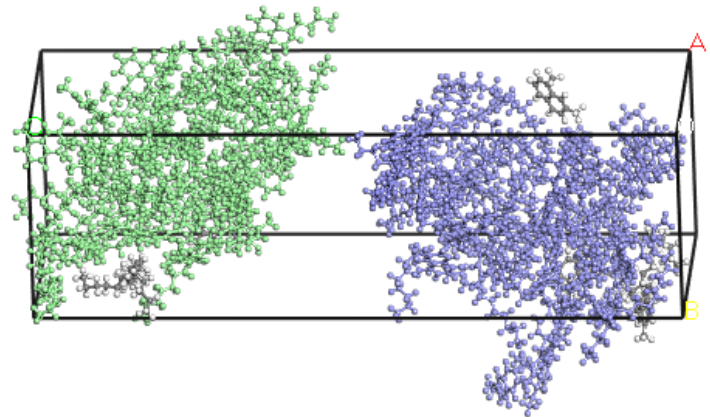
Figure 4. New-old asphalt contact interface model.